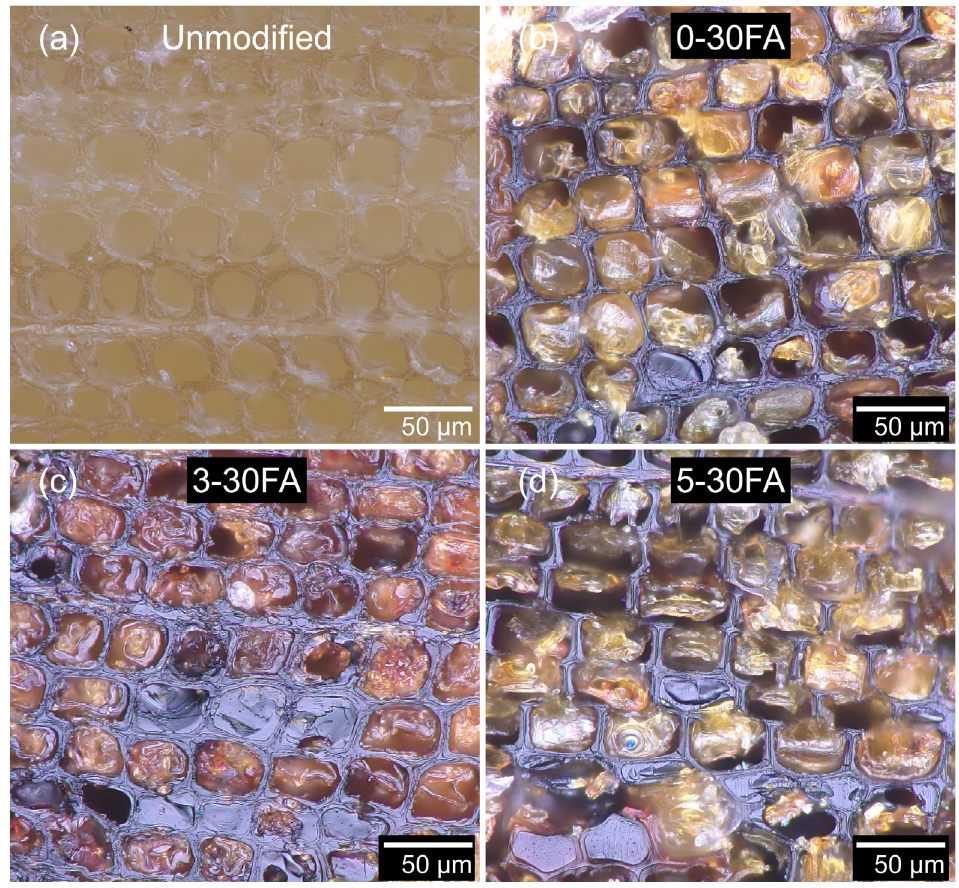
Figure 3. Optical microscope images of cross-sectioned ( a ) unmodified, ( b ) 0-30FA, ( c ) 3-30FA, and ( d ) 5-30FA earlywood specimens. ( d ) 5-30FA earlywood